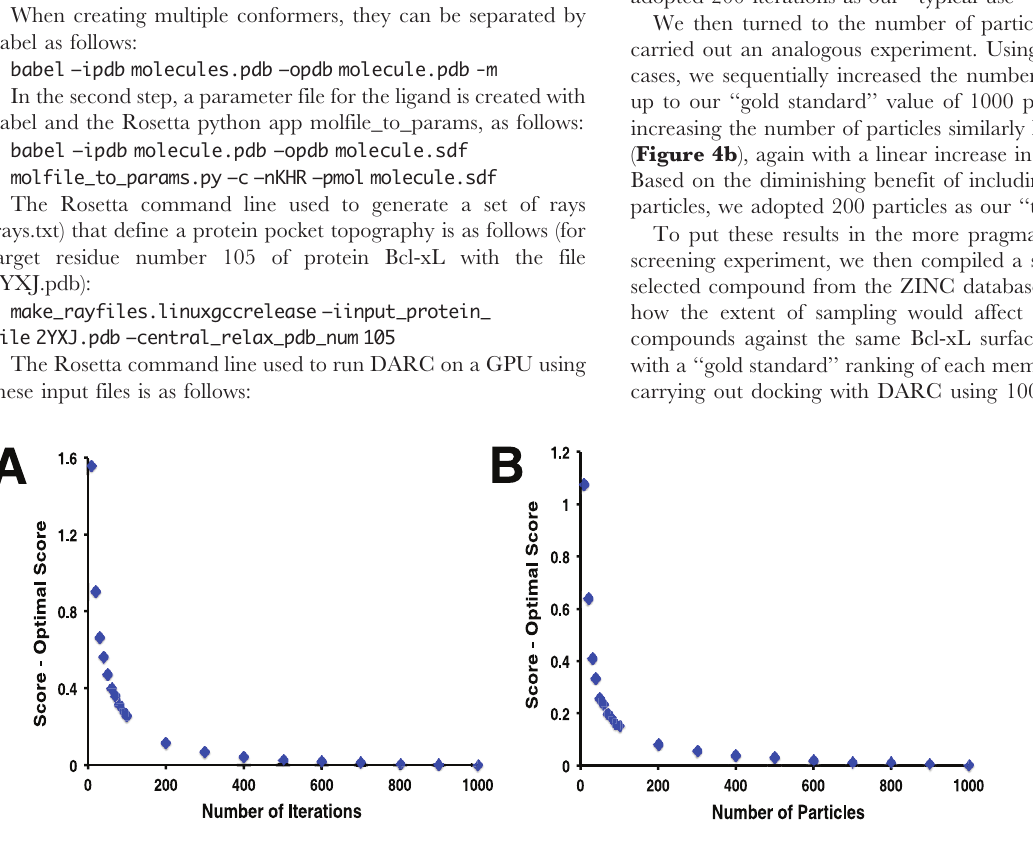
Figure 4. Effect of the number of particles and the number of iterations on DARC score. To determine the number of particles and number of iterations required for reasonable convergence of the DARC score, docking was carried out with ( A ) an increasing number of iterations while holding the number of particles fixed at 200, and ( B ) an increasing number of particles while holding the number of iterations fixed at 200. Differences in score are reported relative to the ‘‘gold standard,’’ taken to be the most extensive simulation in the set (i.e. 1000 iterations or 1000 particles).